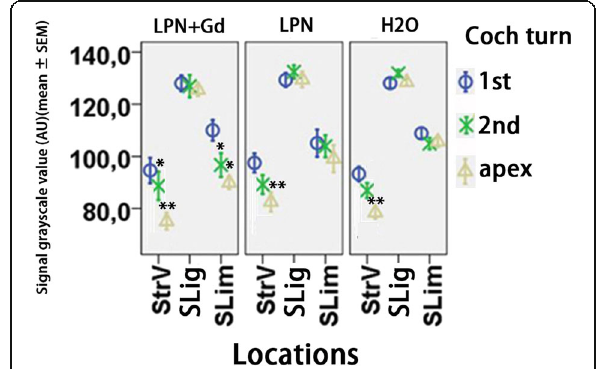
Fig. 6 Quantification of glycosaminoglycan secretion in rat cochlea exposed to liposome nanocarriers detected using periodic acid Schiff ’ s staining. n =3 in each group. AU arbitrary unit, H2O negative control, LPN empty liposome nanocarrier, LPN+Gd Gd-DOTA-containing LPN, SLig spiral ligament, Slim spiral limbus, StrV stria vascularis, 1st basal turn, 2nd second turn. * p <0.05, ** p <0.01 (one-way ANOVA with LSD test used as post hoc